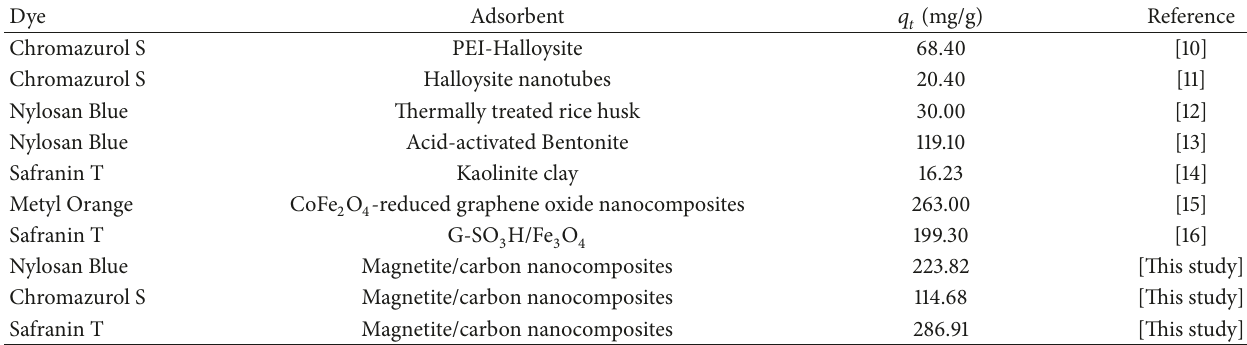
Table 6: Adsorption capacities of magnetic nanocomposites for the adsorption of dyes from aqueous solutions.